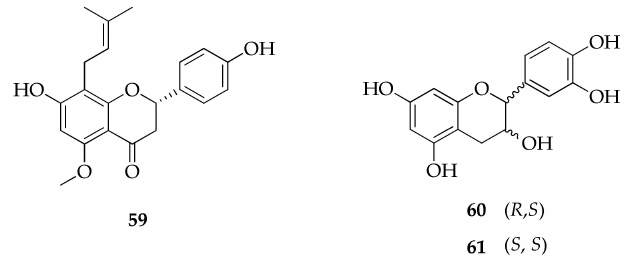
Figure 14. Structures of